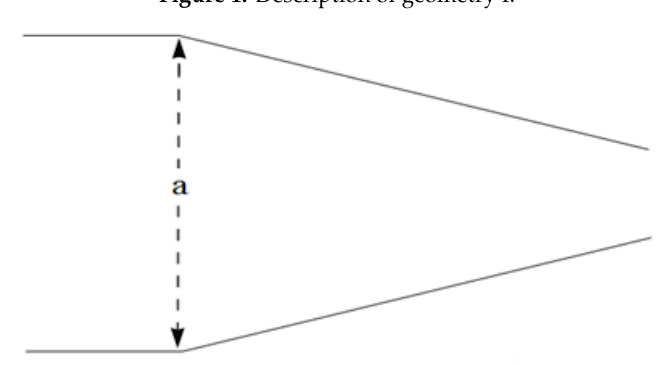
Figure 2. Description of geometry II.